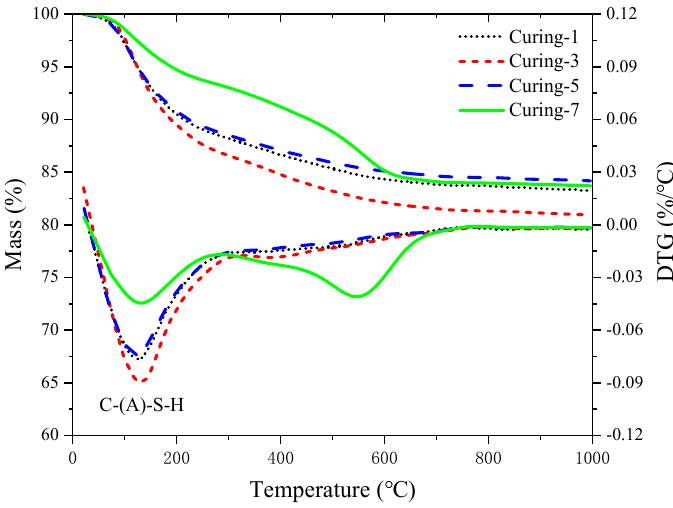
Figure 6. TG-DTG analysis of AAS pastes.